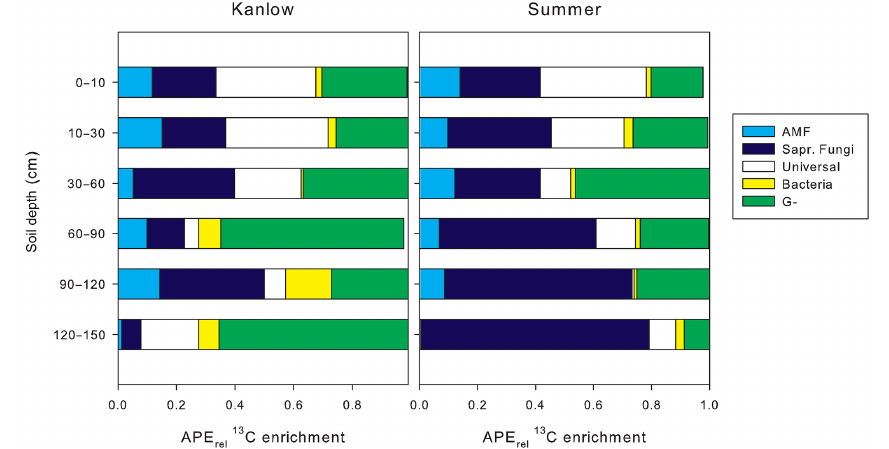
Figure 4. Relative rhizodeposit uptake (PLFA APE rel enrichment), for switchgrass ecotypes Kanlow and Summer at all sampled depths 48h after 13 C labeling. Functional groups actinomycetes and Gram-positive bacteria not included because 13 C enrichment was not obtained in those groups (Tables S1 and